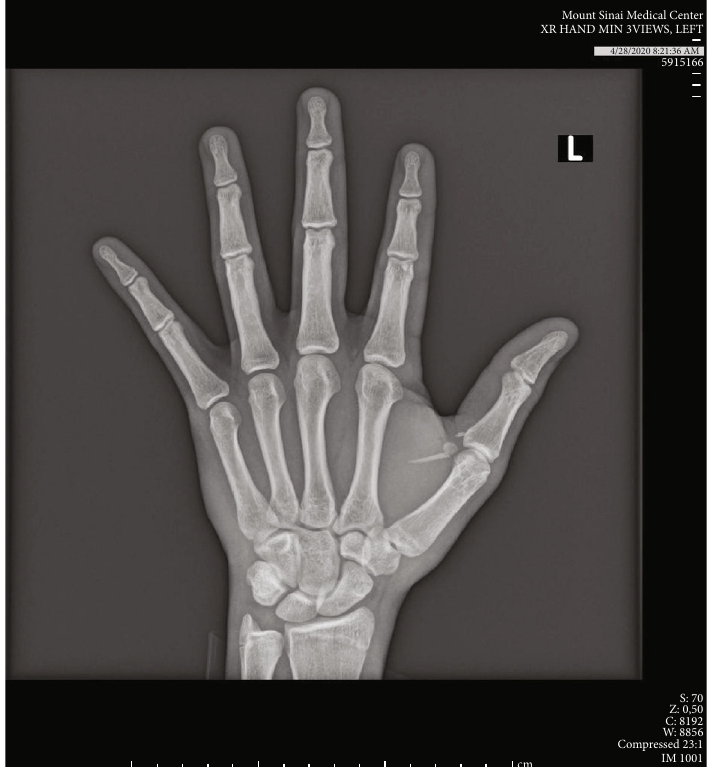
Figure 2: AP radiograph of the left hand demonstrates a 1.7cm linear radiodensity in the thenar region of the left hand which appears extraosseous, compatible with a foreign body. There is no other acute osseous